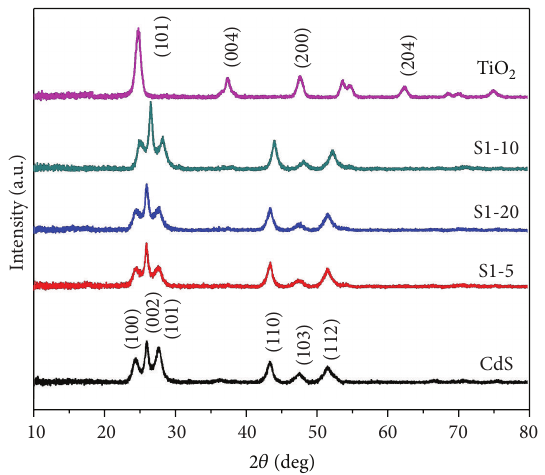
Figure 3: XRD patterns of CdS, S1-10: 10wt% TiO 2 /CdS (10h), S1- 5: 10wt% TiO 2 /CdS (5h), S1-20: 10wt% TiO 2 /CdS (20 h), and TiO 2 ,